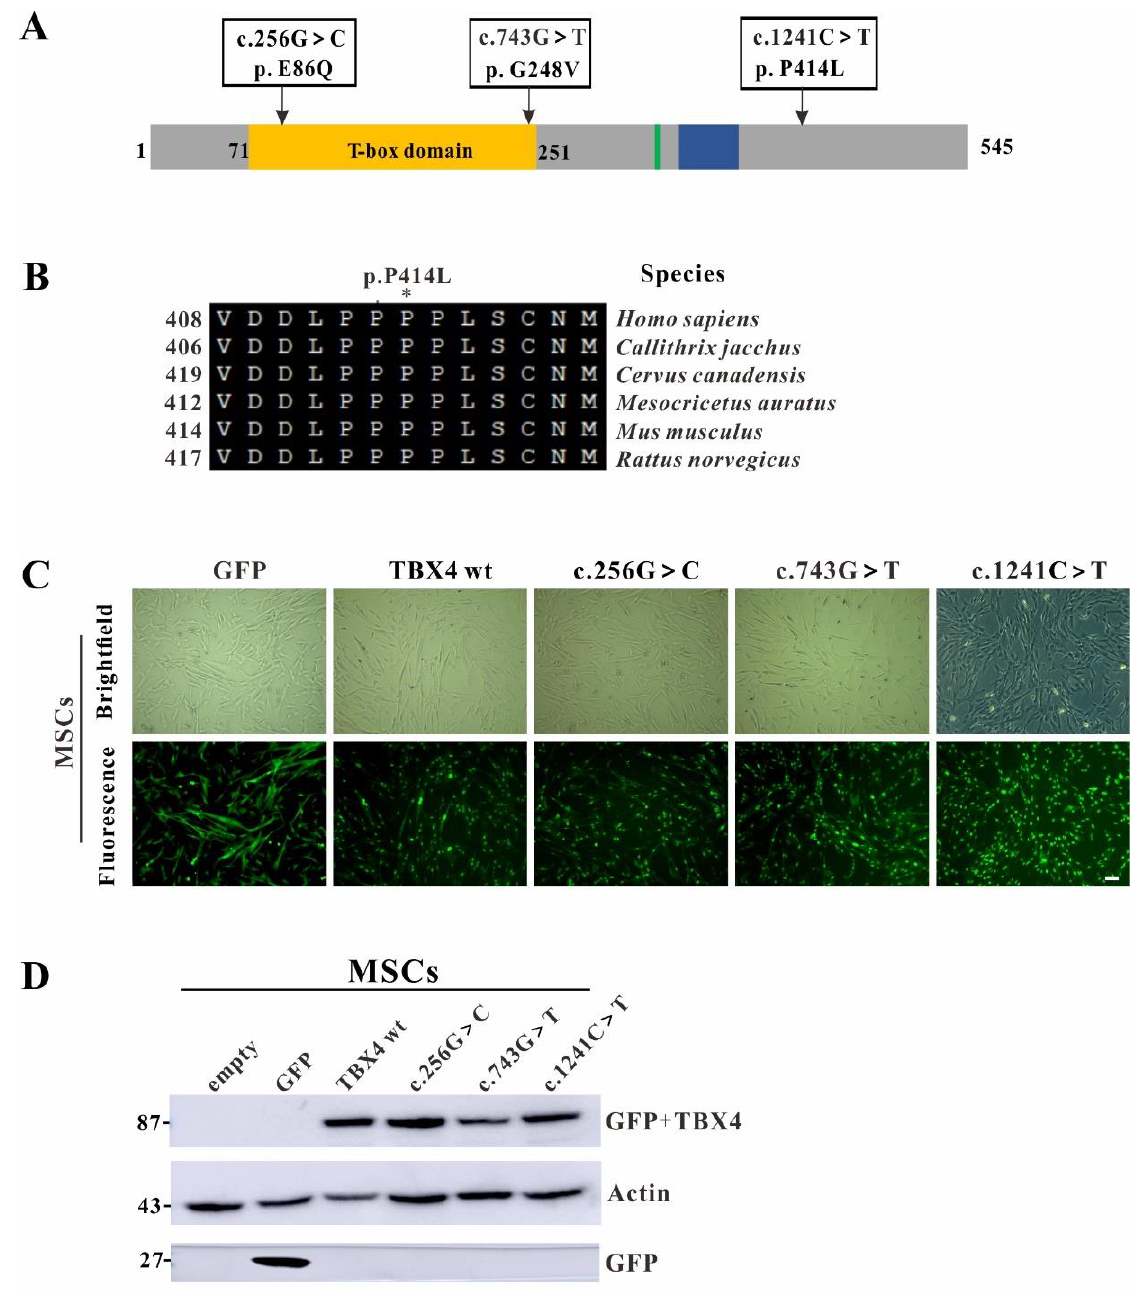
Figure 2. Generation of mesenchymal stem cells (MSCs) cell lines with stable overexpression of either TBX4 wt or TBX4 mt . ( A ) Schematic of the secondary structure and functional domains of the TBX4 protein. The distribution of three mutations in TBX4 are indicated by arrow. The T-box domain, nuclear localization signal and regulatory interaction domain are shown in yellow, green and blue, respectively. ( B ) Conservation of the 414th amino acid in TBX4 protein among different species. NCBI accession numbers are: Homo sapiens : NP_001308049.1; Callithrix jacchus : XP_035156592.1; Cer- vus canadensis : XP_043337426.1; Mesocricetus auratus : XP_040605335.1; Mus musculus : NP_035666.2; Rattus norvegicus : NP_001100504.1. ( C ) Brightfield and immunofluorescence images of the overex- pressed GFP fusion proteins in MSCs. Bar: 200 mm. ( D ) Western blot analysis for stable overexpres- sion MSCs lysates. The molecular weights of expected band are 87 KDa with TBX4 (60 KDa) and GFP (27 KDa) in total.